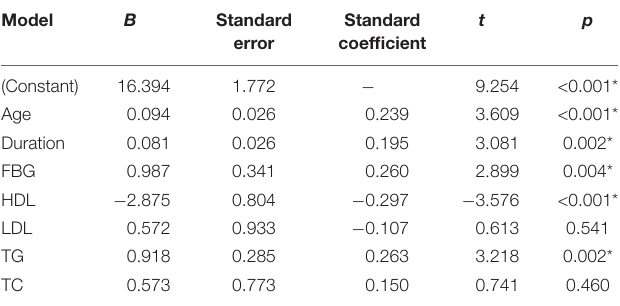
TABLE 3 | Multiple linear regression analysis of influencing factors of BMI in